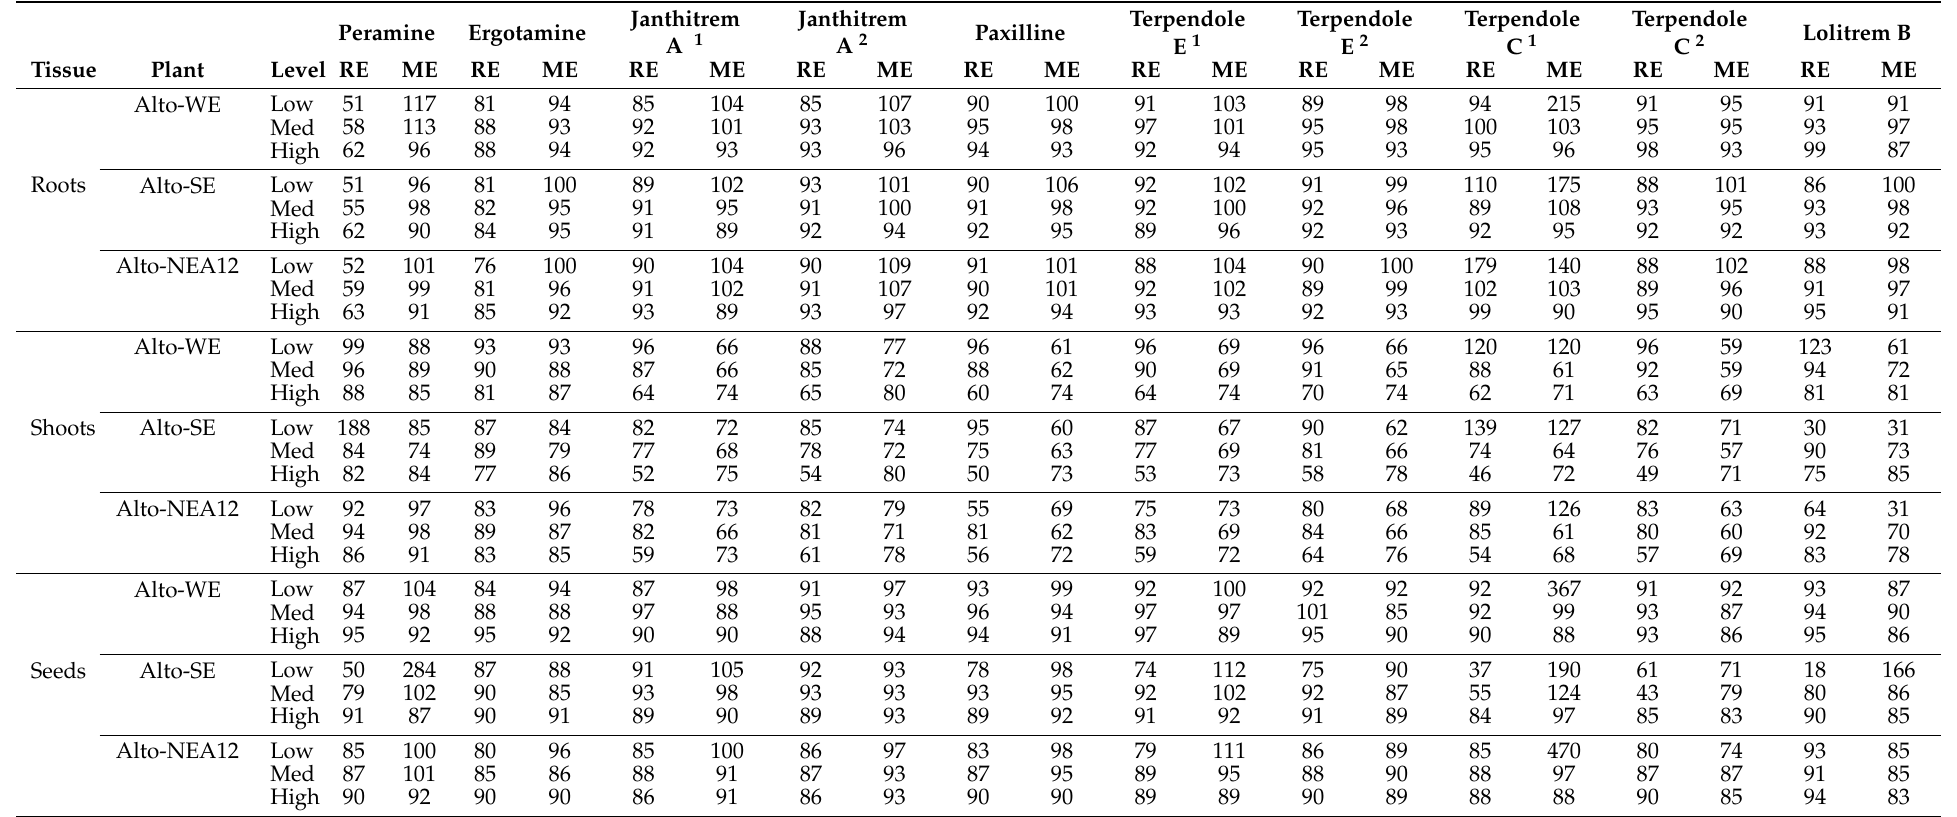
Table 3. The recovery rates (REs, %) and matrix effects (MEs, %) of alkaloid standards spiked at three levels in ground perennial ryegrass shoots, roots and seeds. Peramine Ergotamine Tissue Plant